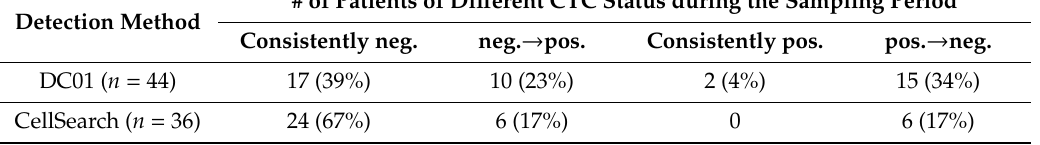
Table 5. Summary of circulating tumor cell (CTC) status detected by both methods before and after radiotherapy in paired blood samples. Detection